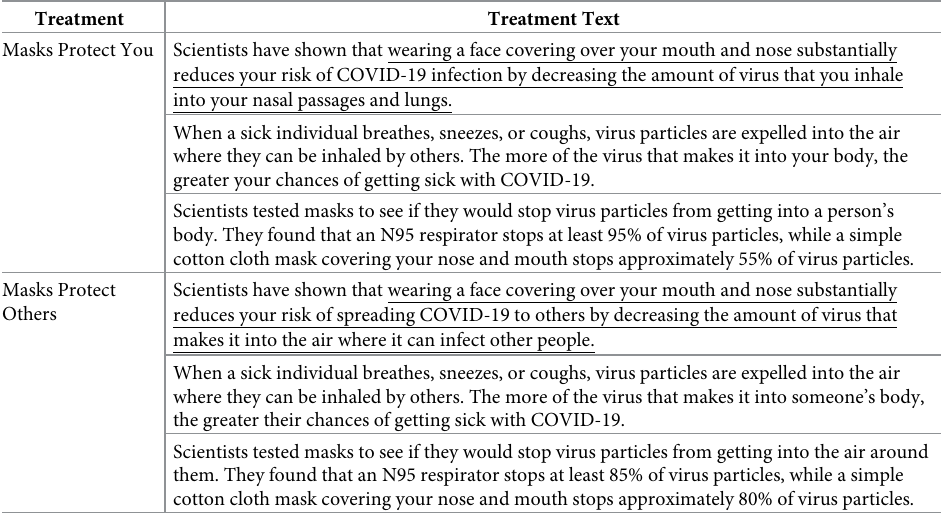
Table 1. Mask belief